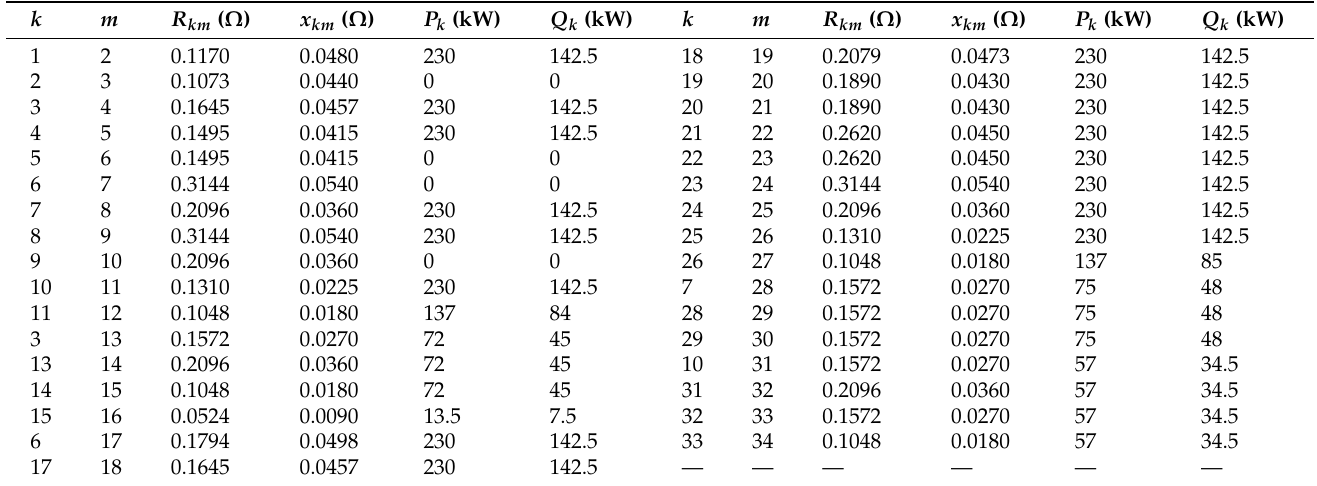
Table 2. Parametric information regarding the IEEE 34-bus Optimal size (bus)